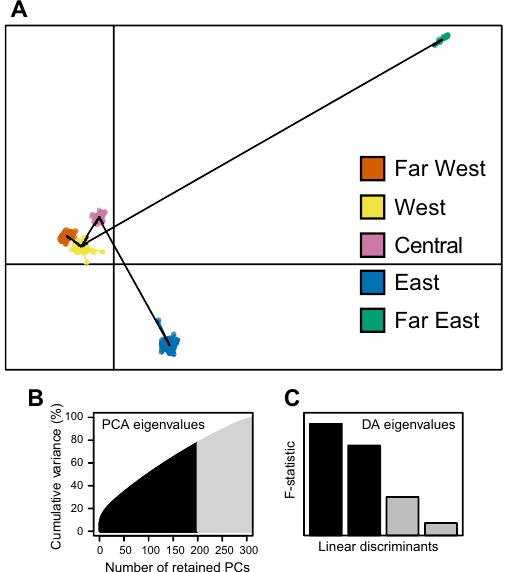
Figure 3. ( A ) Discriminant analysis of principal components (DAPC) scatterplot showing positions of 324 S. famelica and S. eriocephala genotypes along the first two linear discriminants for K = 5. Each dot represents a genotype and a minimum spanning tree (black line) based on the squared distances between the inferred geographic clusters. ( B ) Principal component analysis (PCA) eigenvalues plot shows that 77.3% of the cumulative variance can be explained by the first 200 retained principal components (PCs). ( C ) Discriminant analysis eigenvalues plot shows the proportion of total variance captured by the first two linear discriminants.